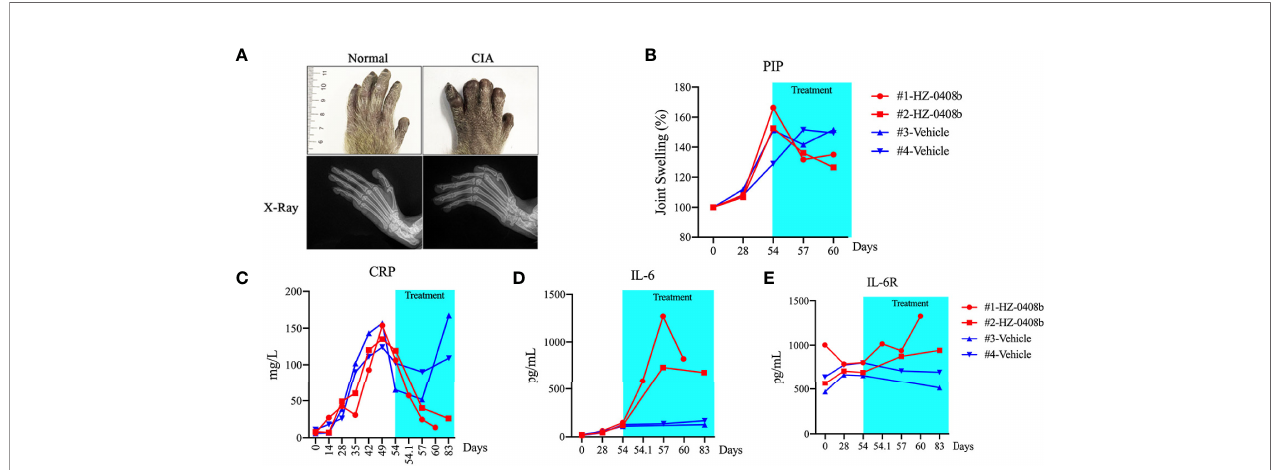
FIGURE 4 | HZ-0408b ameliorates collagen-induced arthritis in cynomolgus monkey. (A) Representative pictures of the monkey joint swelling (top) and X-ray (bottom) before HZ-0408b treatment are shown. (B) Quanti fi cation of swelling of PIP joints in CIA monkeys with HZ-0408b treatment. Each line represents one animal. (C) CRP levels in monkeys treated with or without HZ-0408b. Blood was collected from the femoral vein with a syringe containing heparin sodium at indicated time points. CRP level was measured with an automatic analyzer. Plasma IL-6 (D) and IL-6R (E) levels in CIA monkeys with or without HZ-0408b treatment was measured by ELISA as previously